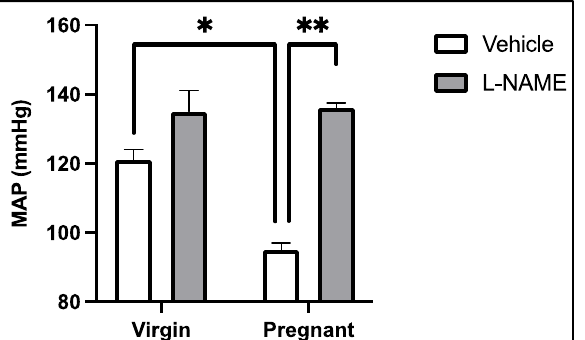
Figure 2. Impact of non-selective NOS inhibition with L-NAME on conscious maternal mean arterial blood pressure (MAP). L-NAME was administered in pregnant rats from gestational day 13–19 in drinking water (Vehicle). * p < 0.05 for virgin vs. pregnant vehicle-treated rats; ** p < 0.05 for pregnant + vehicle vs. pregnant + L-NAME rats. Mean ± SEM. Data adapted from [25].